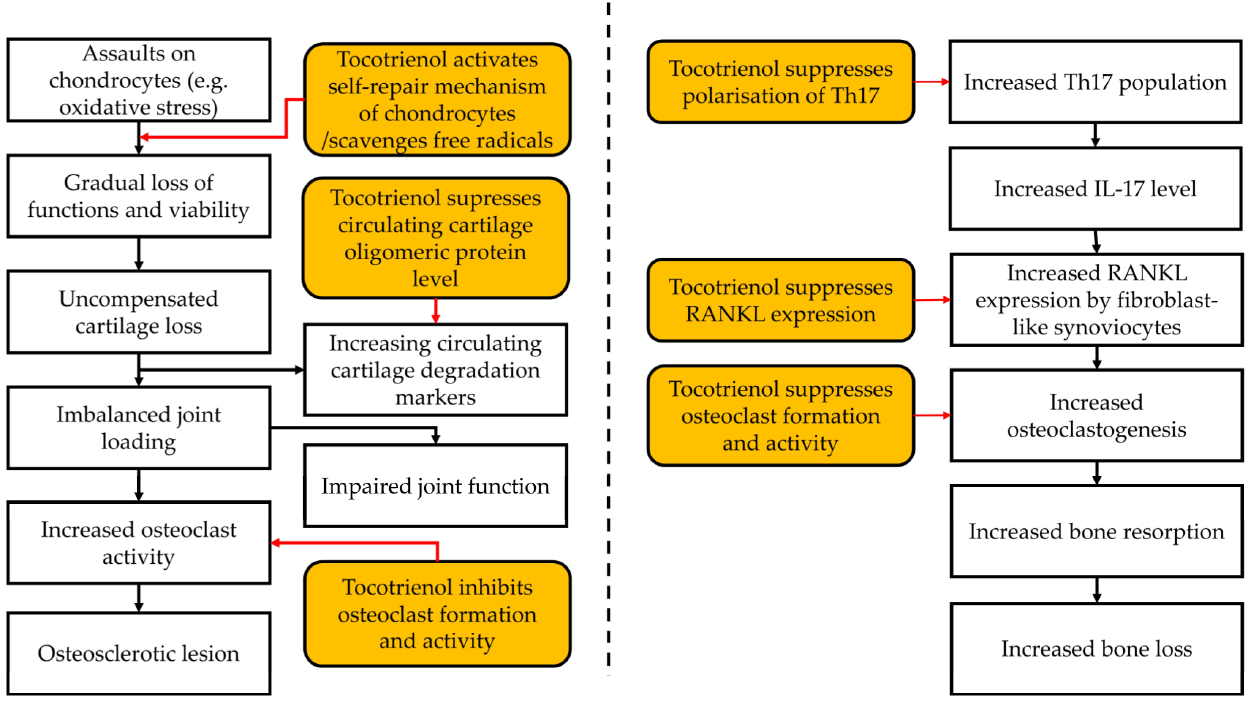
Figure 3. The effects of tocotrienol on OA and RA. ( A ) Effects of tocotrienol on osteoarthritis. ( B ) Effects of tocotrienol on rheumatoid arthritis.